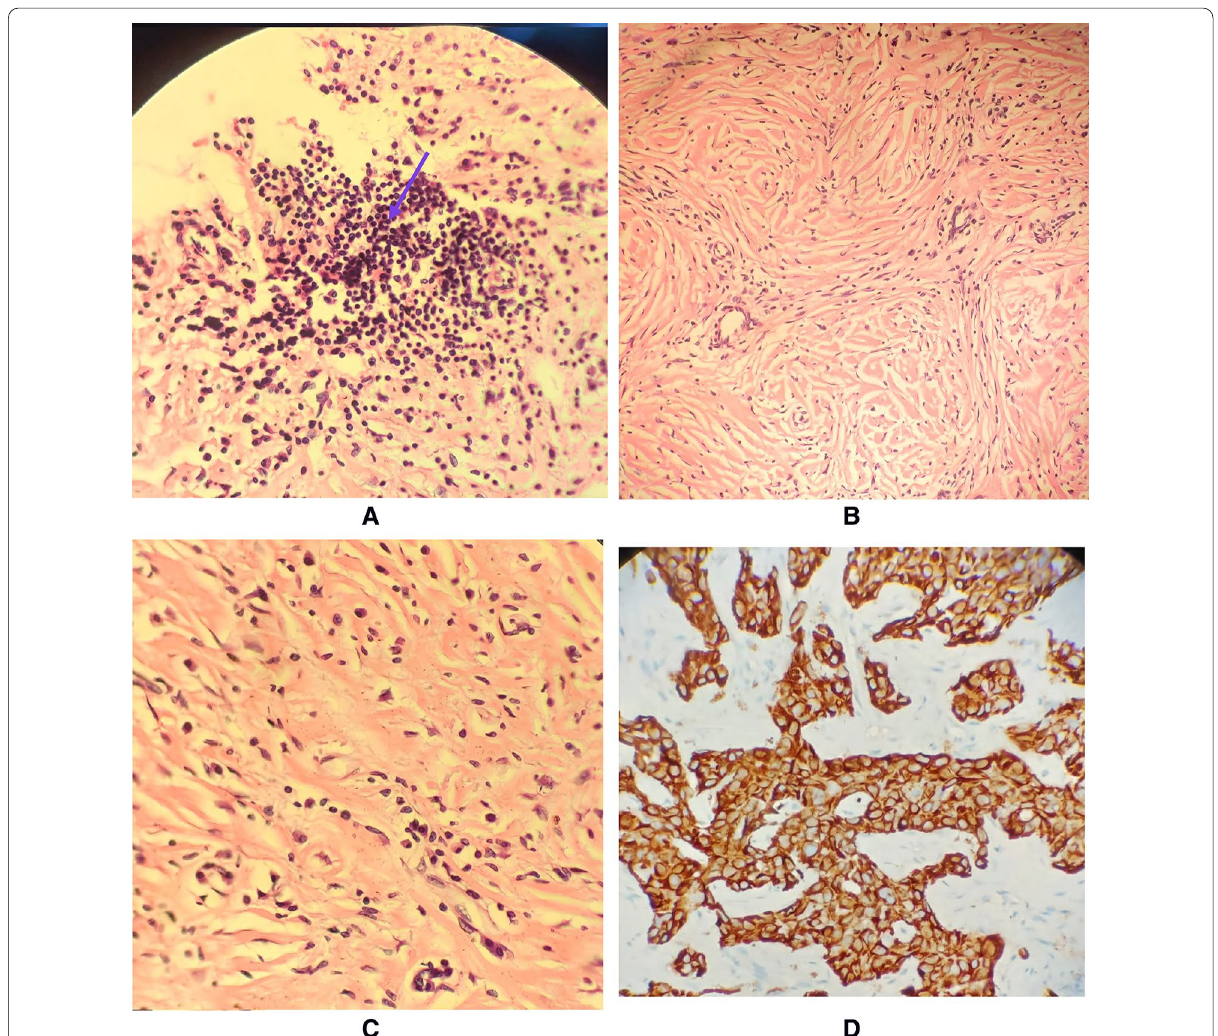
Fig. 2 Histopathology images of the lesion showing a dense lymphocytic infiltrate, b storiform fibrosis with hyalinised collagen, c plasma cell infiltration, d immunohistochemistry showing more than 40% infiltration by IgG4 positive plasma